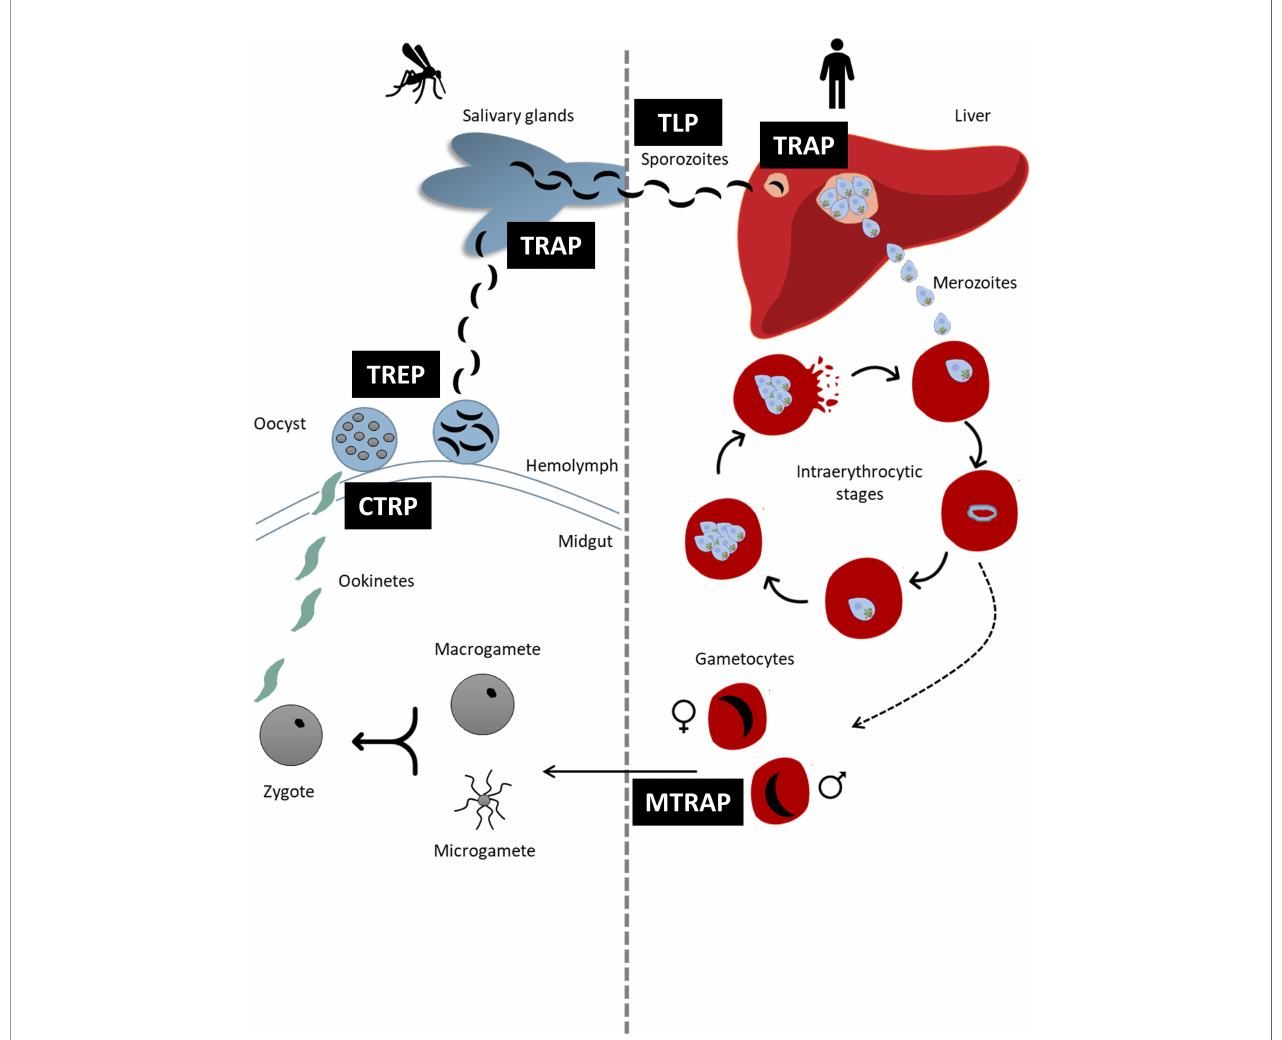
FIGURE 1 | Schematic representation of the life cycle of Plasmodium spp. highlighting the moments in which each TRAP- family protein intervene. Each TRAP- family protein is indicated in black boxes.